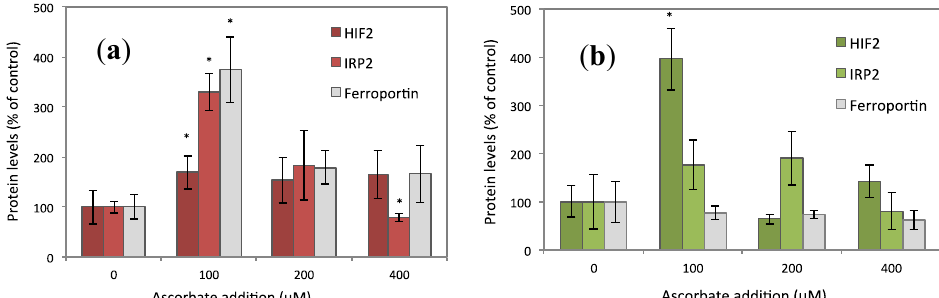
Figure 2. ( a ) Sodium ascorbate was added to the basal medium of Caco-2 cells cultured on permeable Transwell ® inserts. HIF2, IRP2, and ferroportin protein expression was measured with a sandwich ELISA. Data are means ± SD, n = 6. Significant differences from the baseline (0 μ M) are labeled with an asterisk (*). ( b ) The same experiments as in ( a ) were repeated using Caco-2 cells cultured directly on the bottom of the wells. Instead of basal addition of sodium ascorbate, ascorbate was added to the apical medium. ( c ) Intracellular ascorbate levels of cells treated with sodium ascorbate (0, 100, 200, and 400 μ M). Data are means ± SD, n =